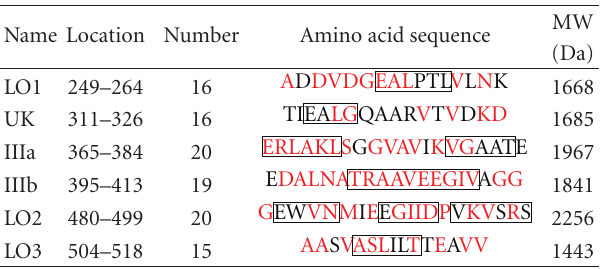
Table 1: Synthetic peptides of Hsp-65 derived from S. sanguinis . MW: molecular weight (daltons) (Oguma et al., 2008) [27].